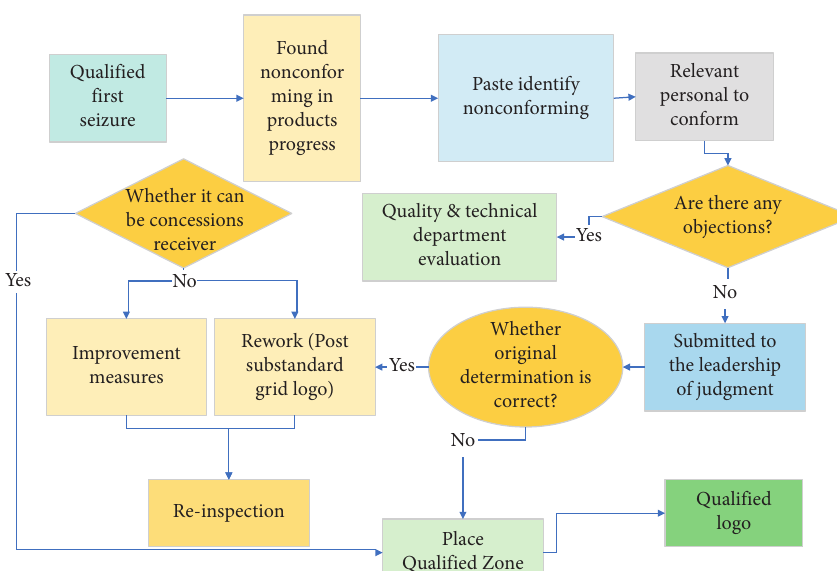
Figure 3: Hotspot evolution analysis process.